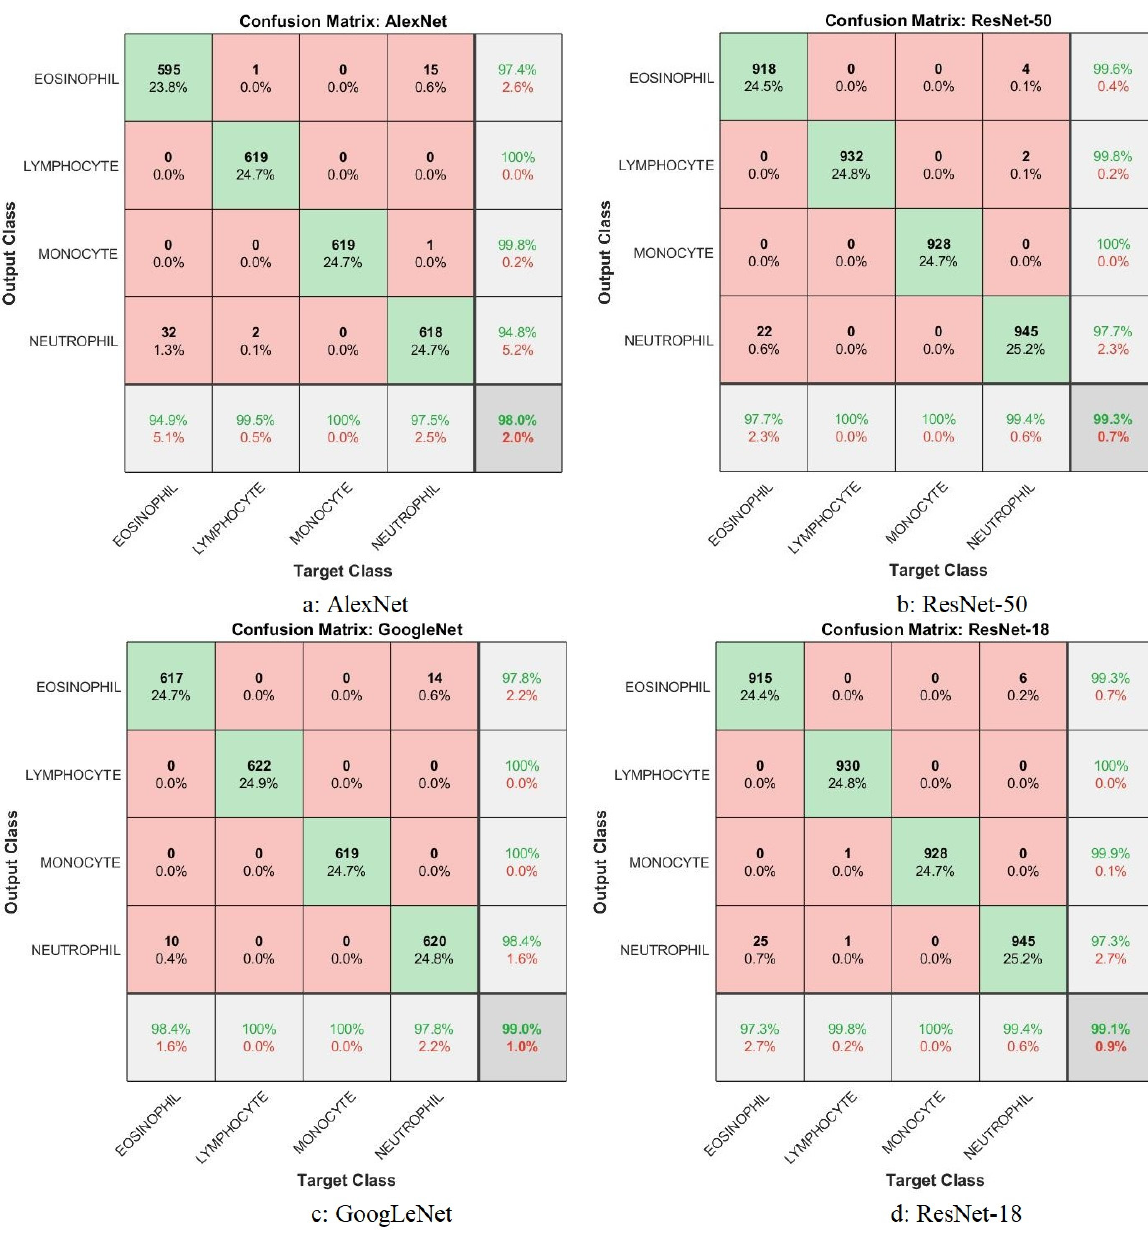
Figure 16. Confusion matrix display for the white blood cell type dataset using ( a ) AlexNet, ( b ) ResNet-50, ( c ) GoogLeNet, and ( d ) ResNet-18.